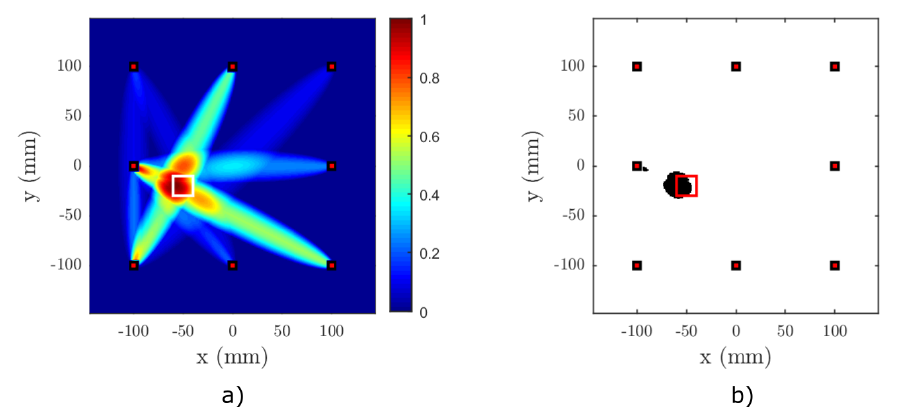
Figure 6. Result of Test Case 1 for nonlinear RAPID imaging on a simulated anisotropic plate, ( a ) without binarization and ( b ) with binary thresholding. The center of the delamination is located at [ − 50, − 20]. The binarization threshold was set to t P = 0.8, the shape factor to β = 1.015 and the SDC threshold to t SDC = 0.25. The actual location of the delamination is marked with a white square in (a) and a red square in (b).